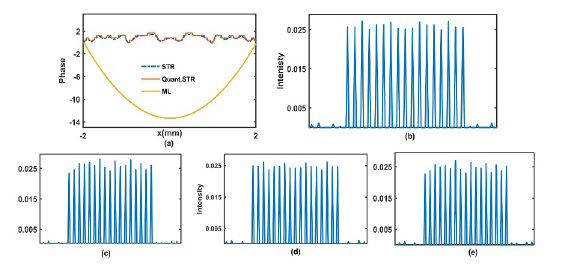
Figure 3. (a) Single periods of the quantized STR and the mi- crolens. (b) Intensity distribution of the signal spots, (c-e) Inten- sity distribution of the signal spots for alignment error of 1 µ m in lateral x, y and both x and y directions .